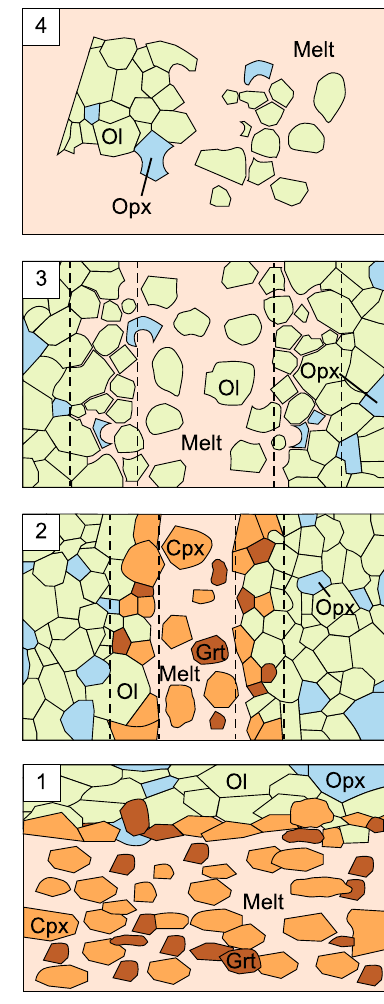
Fig. 4 | Schematic diagram of the model for the formation of Hawaiian shield basalts. a schematic illustration of the high-pressure crystallization model. b details of this model. 1, deep magma chamber; 2, deep magma channels; 3, shallower magma channels; 4, crustal magma chamber. In the deep magma chamber and channels (1 and 2), magma precipitates large amounts of clinopyr- oxene and garnet due to temperature decrease. A thin layer composed of olivine,